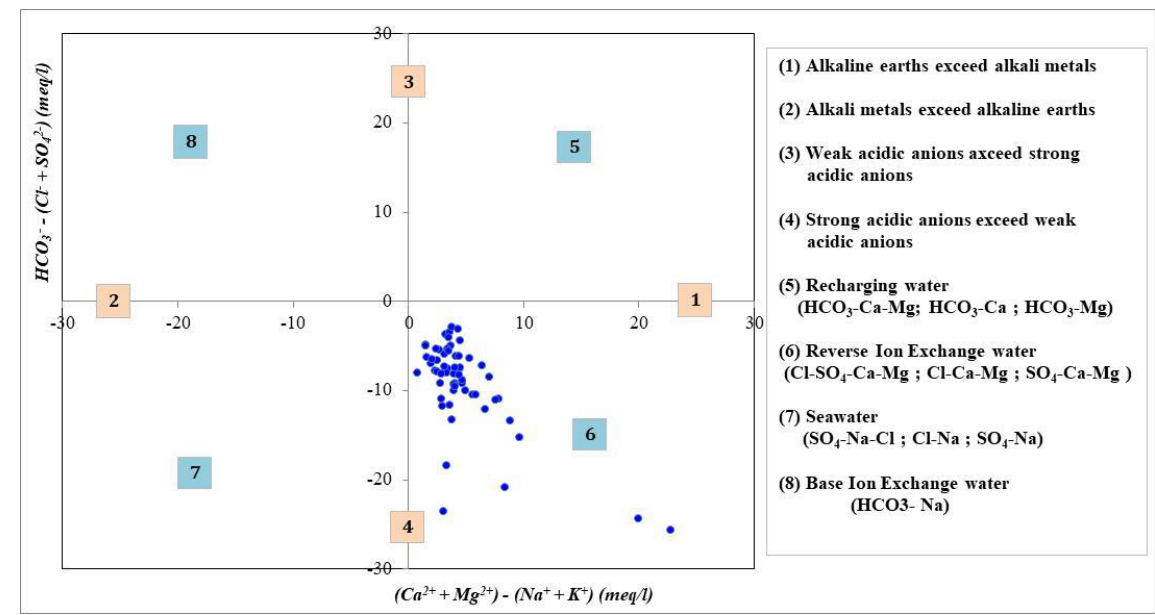
Fig. 3. Chadha diagram